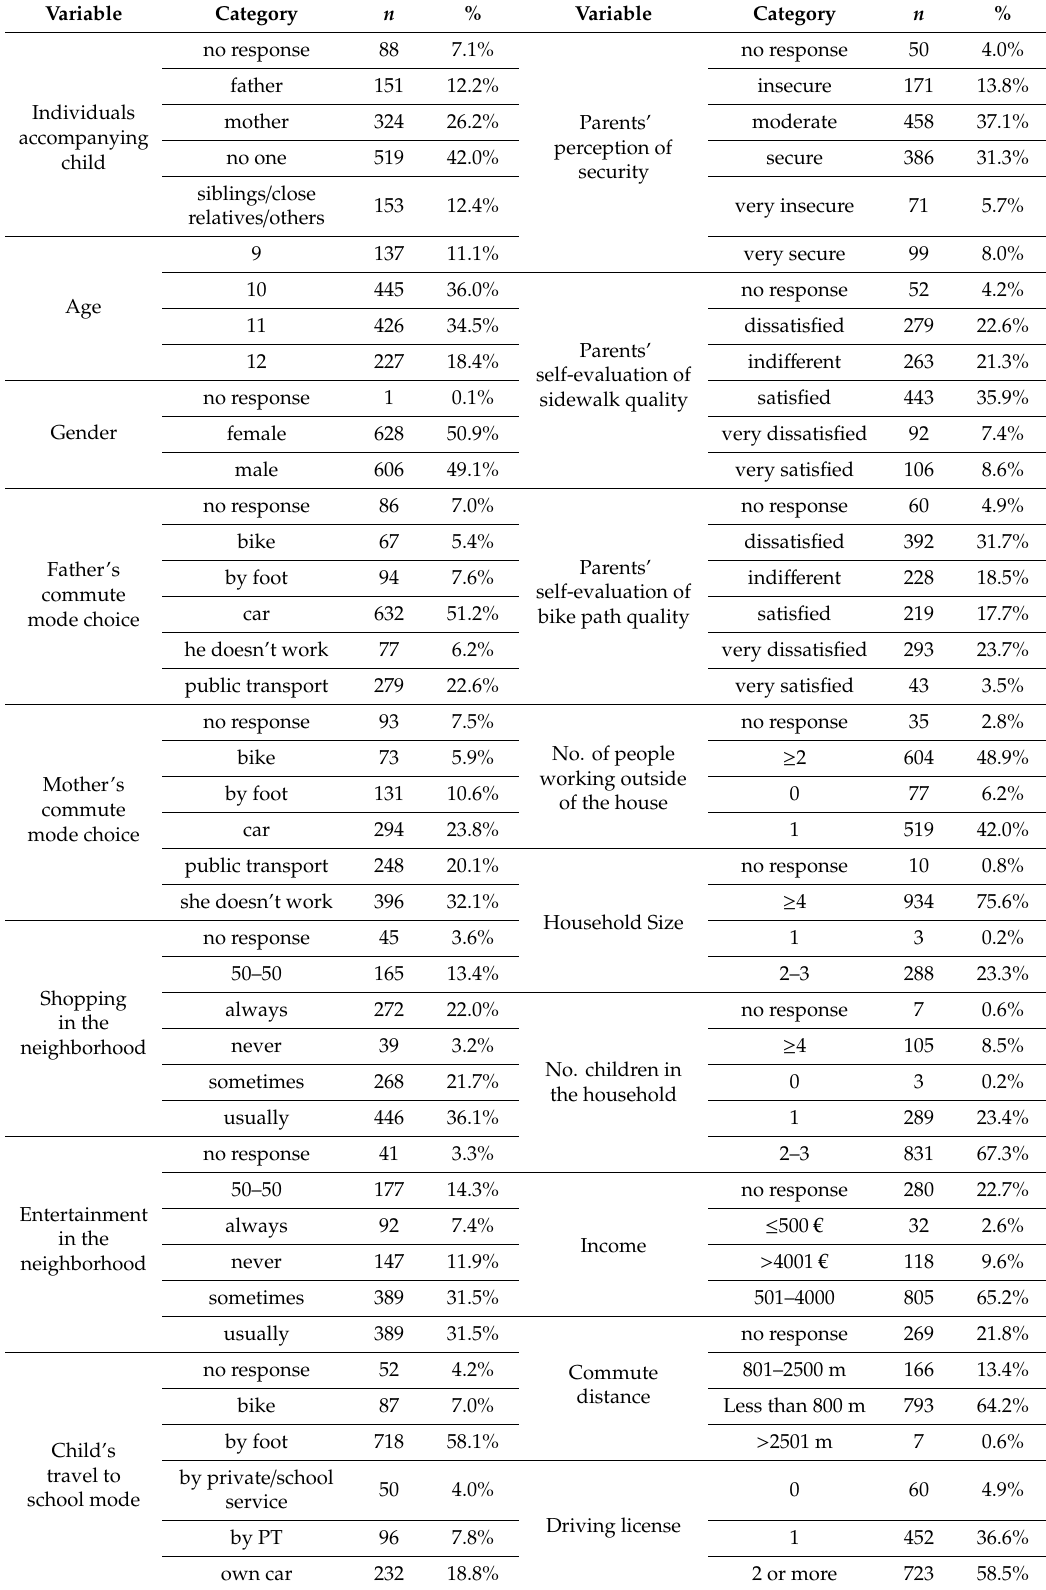
Table 1. Categorical variables applied in this study and their frequencies and marginal percentages ( n = 1304). Variable